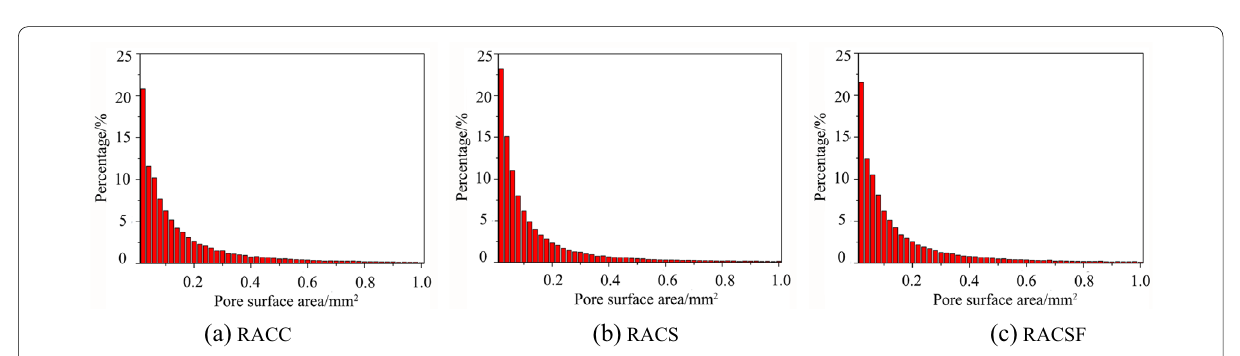
Fig. 8 Influence of admixtures on the pore surface area distribution